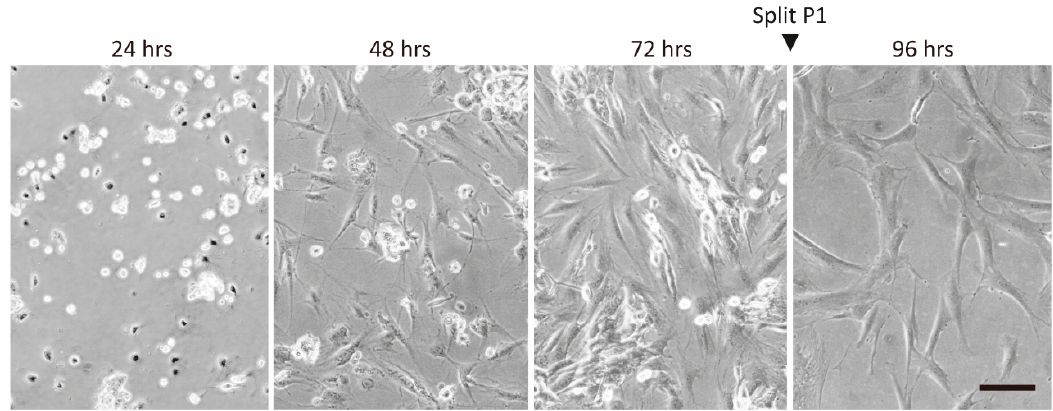
Figure 1. Development of adipose-derived stromal / stem cell (ASC) morphology after isolation (P0), and establishment of passage 1 (P1). Original magnification 200 × . Scale bar indicates 100 µ